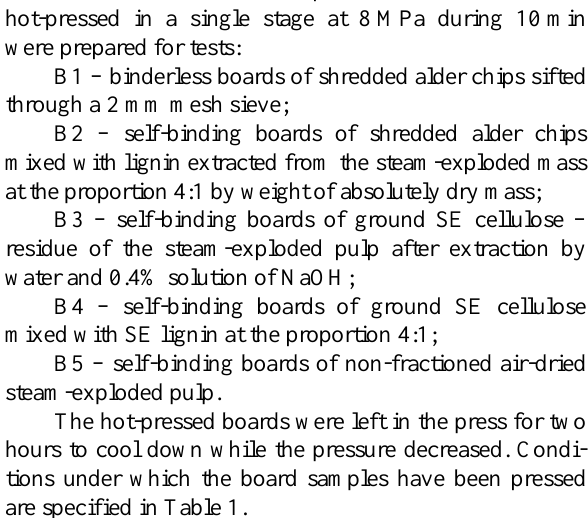
Table 1 . Processing regimes of hot-pressed board sample. In all cases the pressing pressure was 8 MPa and the dura- tion 10 min Sample